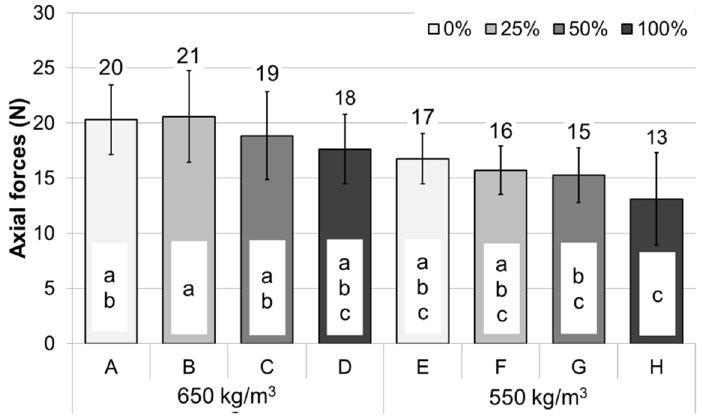
Figure 5. Axial forces during drilling, a–c correspond to the homogeneous groups by Tukey test ( α = 0.05).